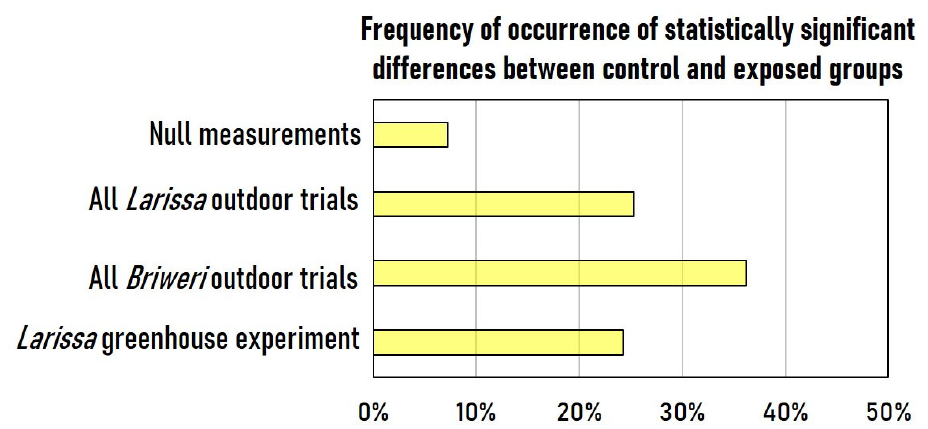
Figure 1. The degree of variation between the control and RF ‐ EMF ‐ exposed groups in OJIP analysis. The graph represents the frequency with which a statistically significant difference could be found when comparing all 50 OJIP variables of the control and exposed plants measured on the same day. Null measurements are those obtained before the RF ‐ EMF is activated. Changes in both directions are counted regardless of whether the value increased or decreased. While the difference between two groups was minimal in the null measurements, the degree of variance rose once the RF ‐ EMF was turned on.